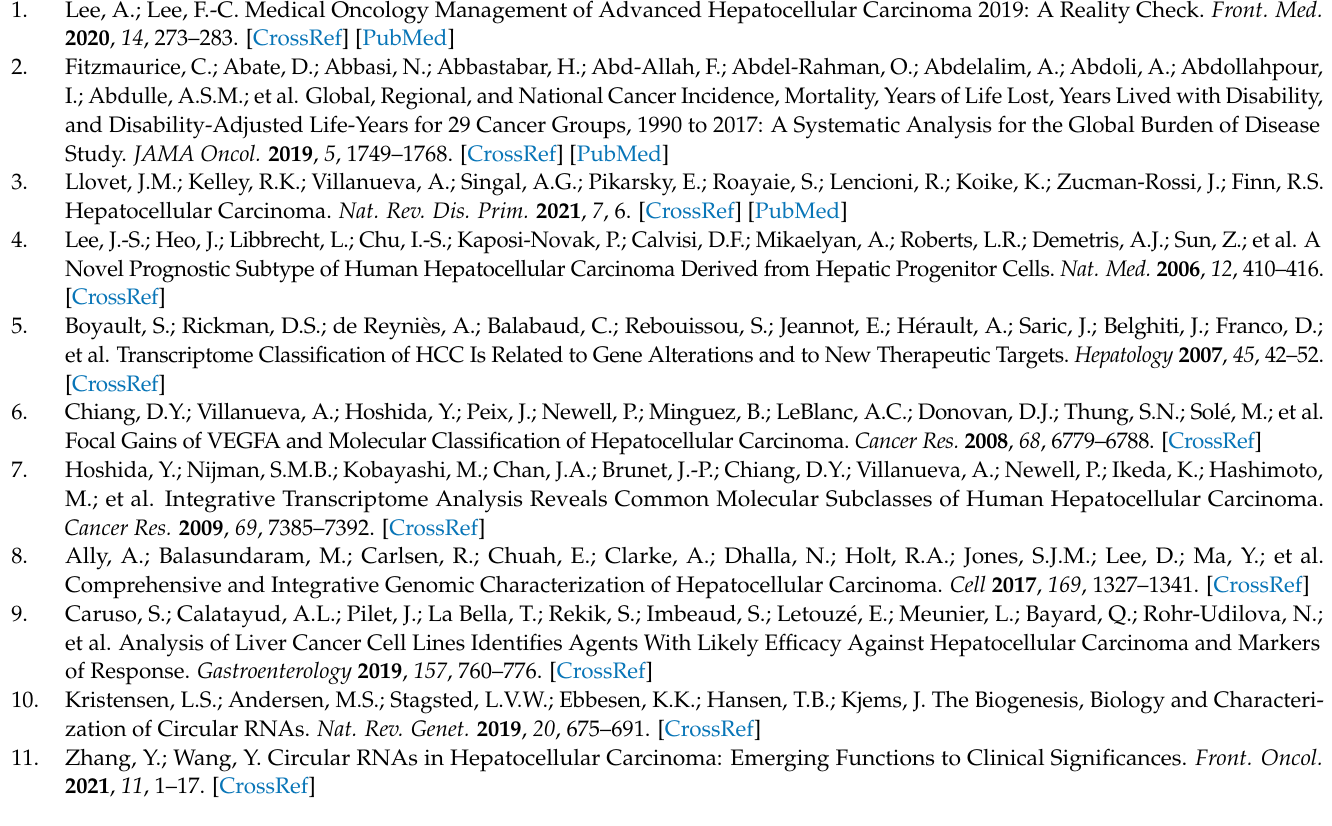
SNU-449 knockdown. Table S8: Potential binding sites of RBPs in hsa_circ_0062682 identified in silico. Table S9: Proteomics analysis of biotinylated oligonucleotide pulldown experiment. Table S10: Enriched Reactome and KEGG pathways in STRING analysis of proteins identified by proteomics analysis. Supplementary data: Uncropped images of whole western